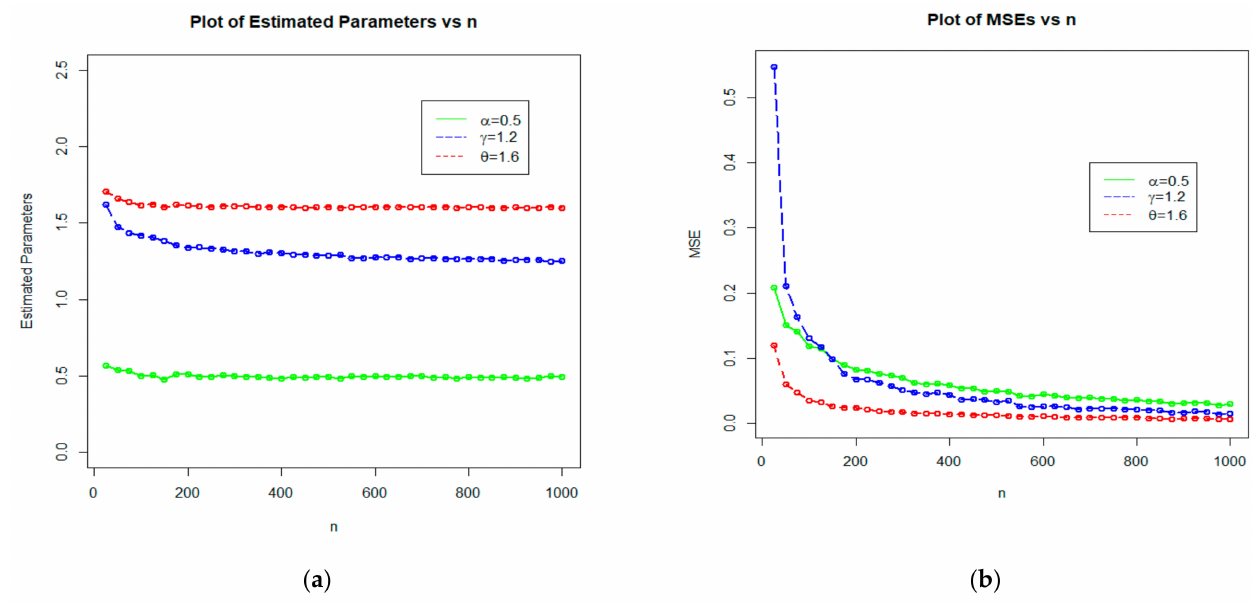
Figure 9. Plots of ( a ) estimated parameters vs. n, and ( b ) MSEs vs. n for Set 3: α = 0.5, γ = 1.2, θ = 1.6.